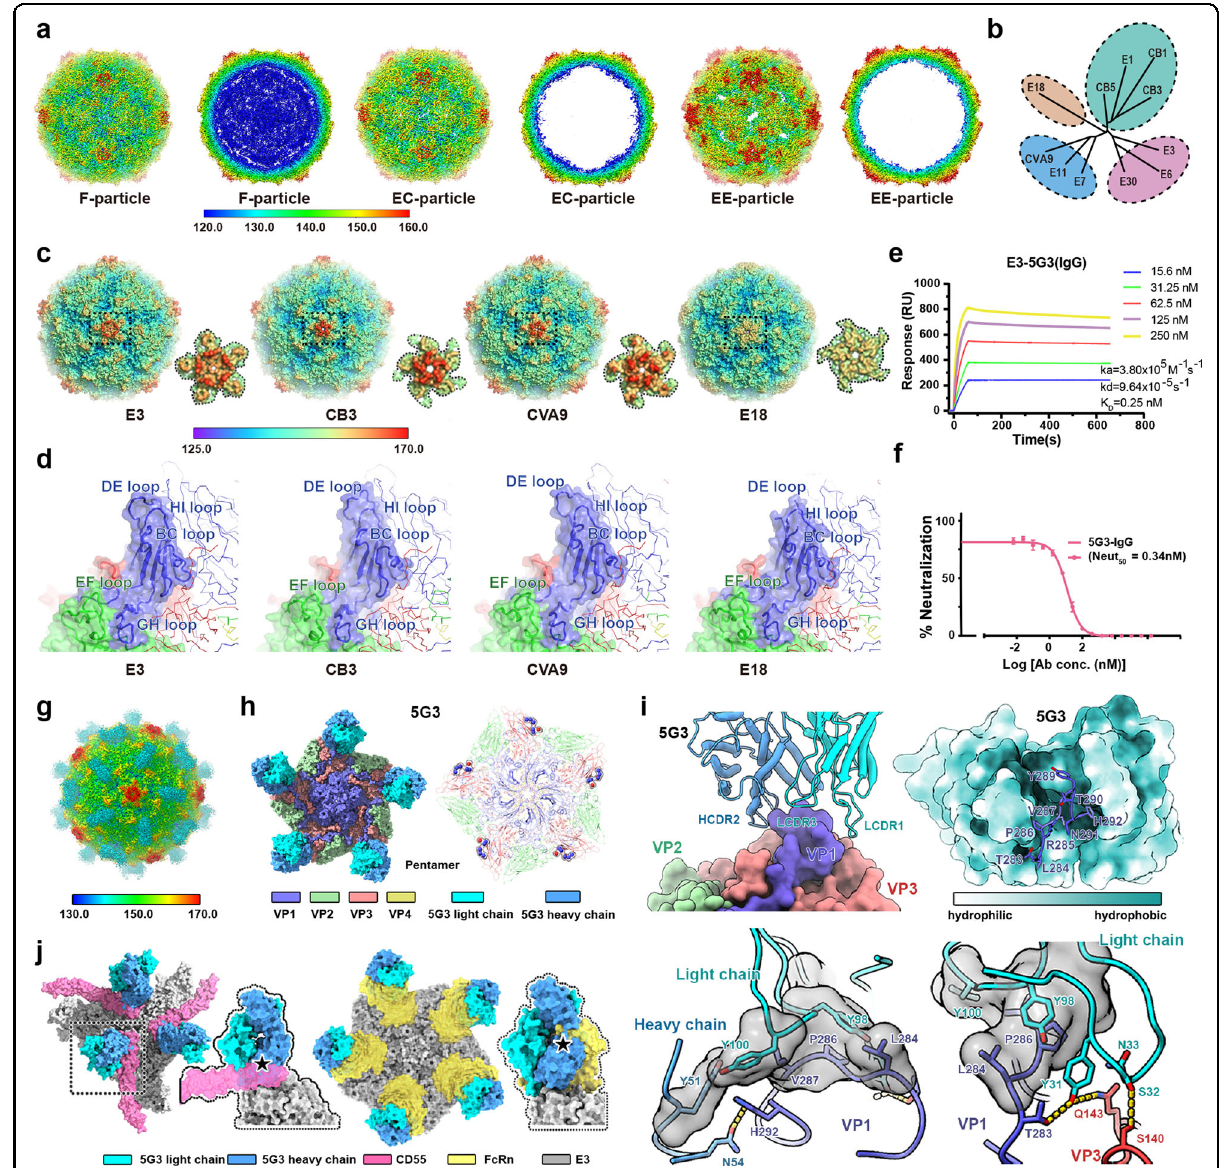
Fig. 1 Structural, biochemical, and immunogenic analysis of E3 particles. a Surface representations of E3 F-, EC-, and EE-particles and thin slices of the corresponding central sections viewed along the two-fold axes, respectively. The surface of the virus is colored by rainbow-color based on the distance of the viral elements from the center, starting with blue (closest) through green, yellow, and orange to red (farthest from the center). b Structure- based evolutionary relationship among the representative viruses from HEV-Bs: E18, echovirus 18; E3, echovirus 3; CVB1, coxsackievirus B1; E6, echovirus 6; E30, echovirus 30; CVB5, coxsackievirus B5; CVB3, coxsackievirus B3; E1, echovirus 1; CVA9, coxsackievirus A9; E11, echovirus 11. c Comparisons of the surface of E3 F-particle with those of other representative members of HEV-B (E18 (PDB: 6HBG), CVB3 (PDB: 4GB3), and CVA9 (PDB: 1D4M)). The color scheme is the same as in a . The “ mesa ” located at the top is marked using a black dotted square for each particle. d Structural details of the protomer (VP1: blue; VP2: green; VP3: red) of representative particles. The loops surrounding the canyon walls (VP1 BC loop, VP1 GH loop, and VP2 EF loop) and the loops surrounding the “ mesa ” structures are labeled in corresponding colors. e The binding af fi nities of E3 F-particle to 5G3 IgG estimated by SPR. f Neutralization of E3 by 5G3 using plaque-reduction neutralization test (PRNT). The Neut 50 value of 5G3 was 0.34nM. g Surface representation of E3-5G3 complex. The viral capsid is colored the same as in a , and the 5G3 Fab is colored in cyan. h 5G3 Fab occupancy (left) and epitopes (right) located on viral pentamer. The pentamer is shown as surface (left) and cartoon (right), respectively. Residues comprising 5G3 epitope are shown as spheres. i The E3 – 5G3 binding interface. 5G3 are shown as cartoon, while E3 is shown as surface. The residues of the VP1 C-terminal (blue) insert into the 5G3 Fab hydrophobic pocket. The change of color re fl ects hydrophilic or hydrophobic nature of the residues, ranging from white (hydrophilic) to cyan (hydrophobic). Residues involved in the interactions between the virus (VP1: blue, VP3: red) and 5G3 are shown as sticks, and the hydrophobic interactions are shown as surface and colored in grey. Hydrogen bonds are marked as yellow dashes. j Clashes between 5G3 and two E3 receptors, CD55 (left)/FcRn (right). The pentamer, 5G3 light chain, 5G3 heavy chain, receptor CD55, and receptor FcRn are colored in grey, cyan, blue, magenta, and yellow,